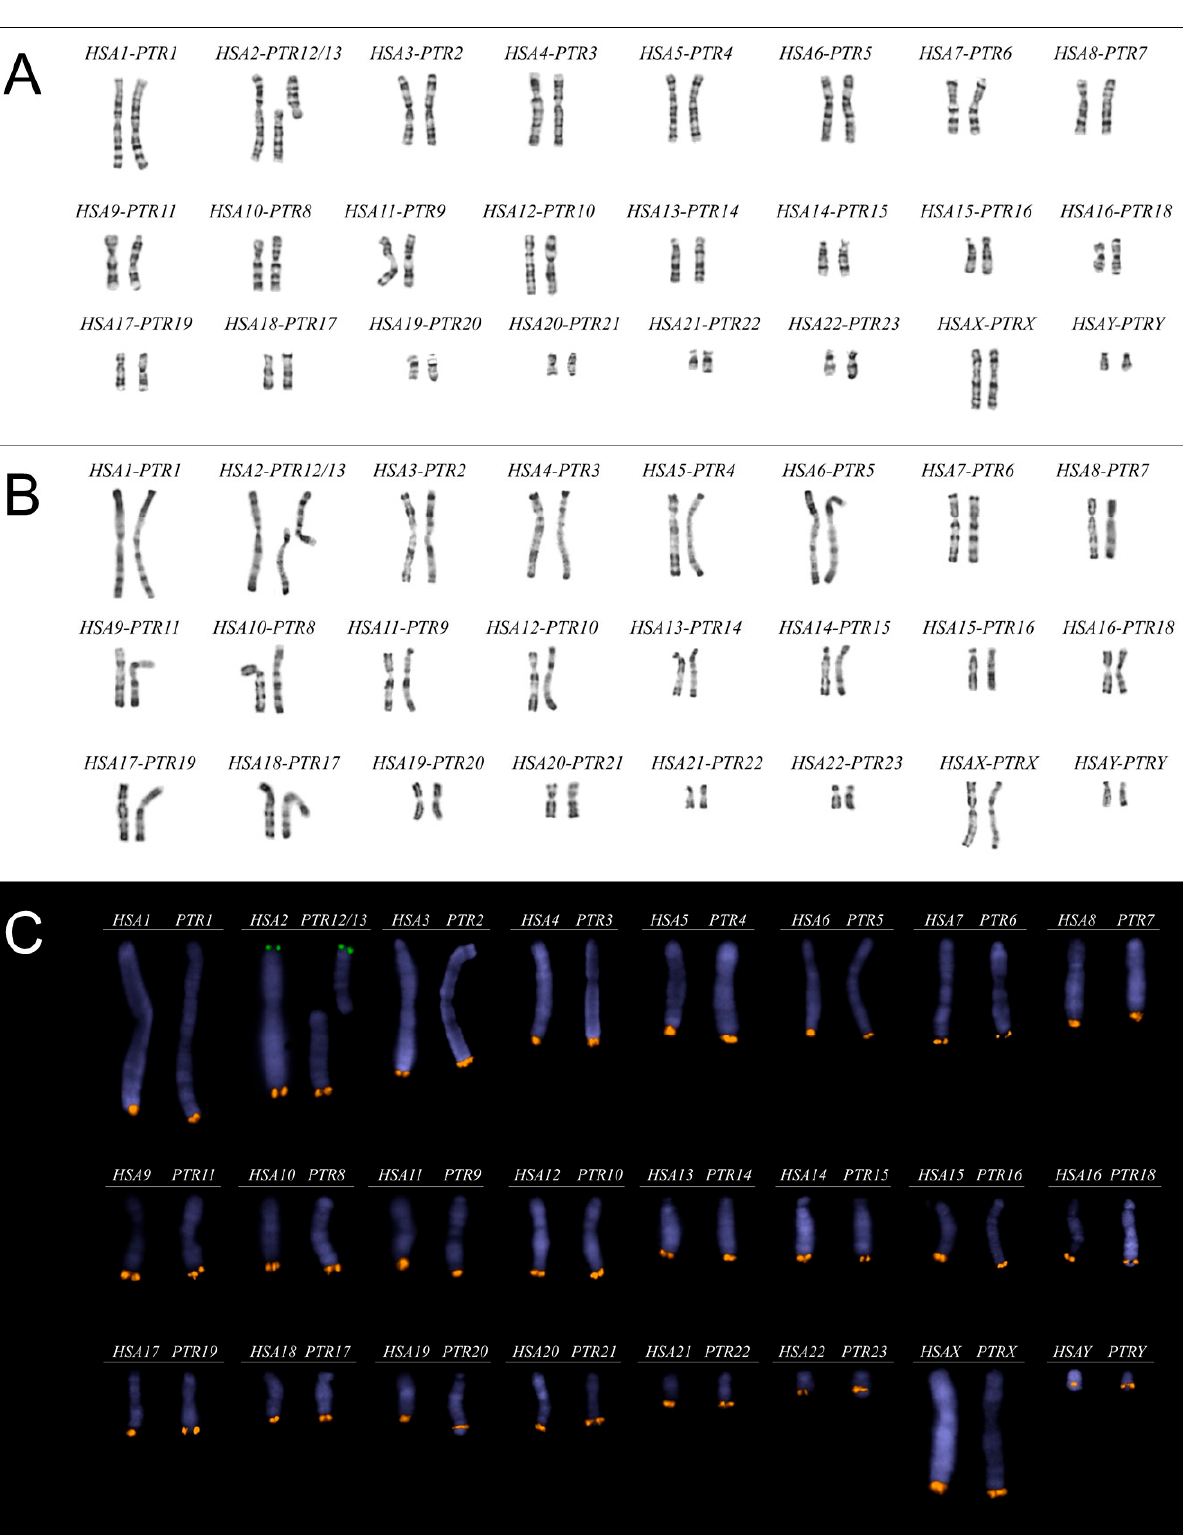
Figure 1. ( A ) G-banding and ( B ) R-banding karyogram of Homo sapiens and Pan troglodytes. ( C ) Fluorescent karyogram with positions of all probes used for chromosome enumeration. For each pair, human chromosomes (HSA) are positioned on the left and chimpanzee chromosomes (PTR) on the right. Probes from the short arm of human chromosome 2 and chimpanzee chromosome 13 were labeled in Spectrum Green and the others in Spectrum Orange (the color combinations used for the analyses are listed in the Material and Methods section).